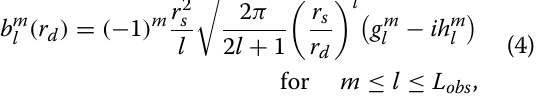
Table 1 Geomagnetic field models and the highest degrees used in assimilation Observations